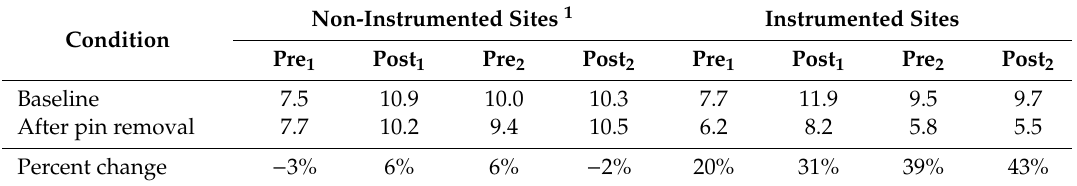
Table 17. MNT values (kg / cm 2 ) in response to Steinman pin placement [29]. Condition